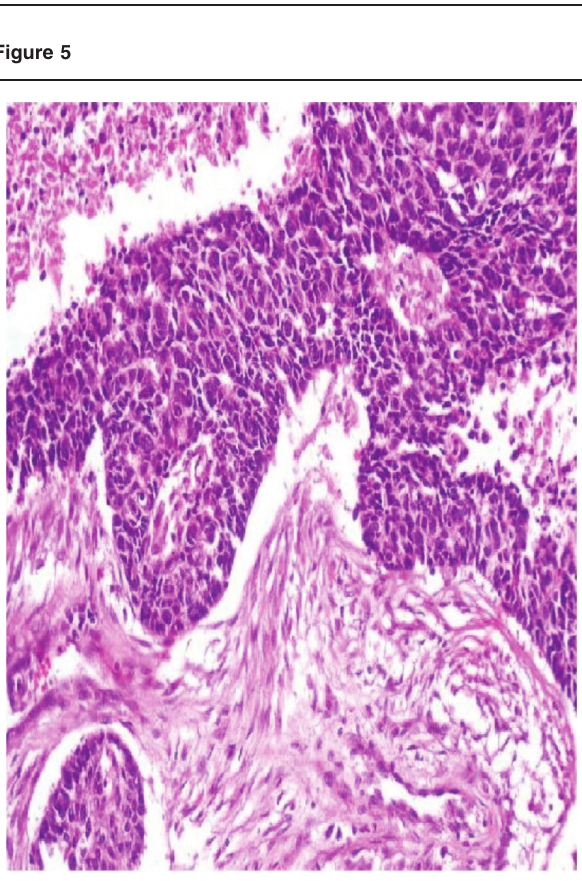
A biopsy specimen was taken from a lung mass showing poorly differentiated squamous cell carcinoma (hematoxylin and eosin stain,